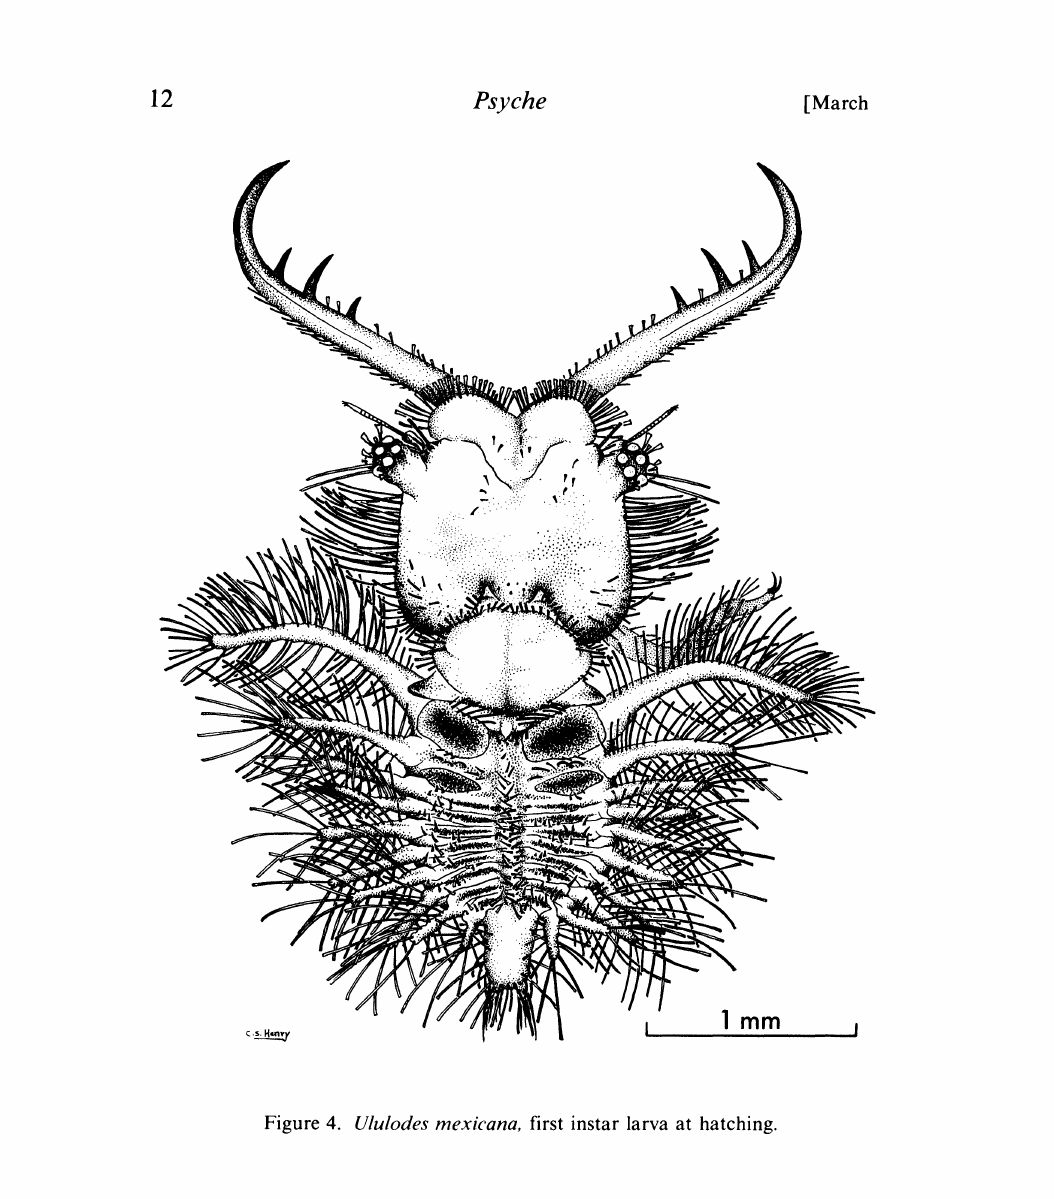
Figure 4. Ululodes mexicana, first instar larva at